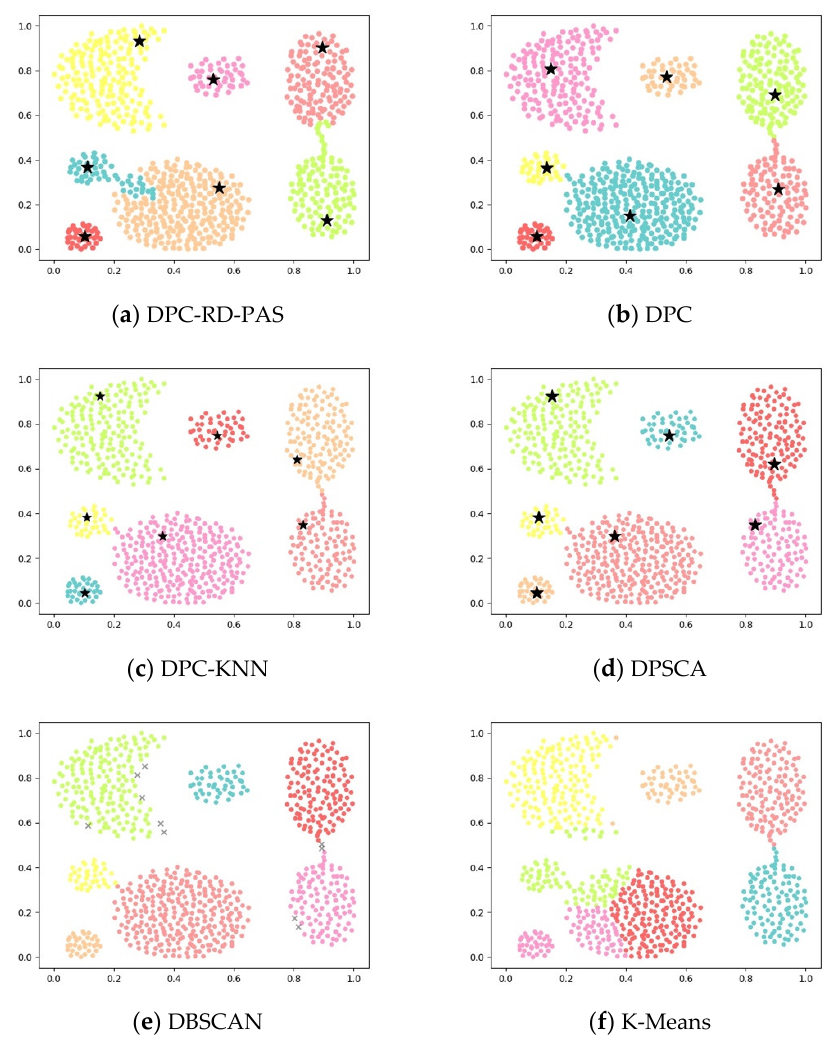
Figure 9. Clustering results on the Aggregation dataset.